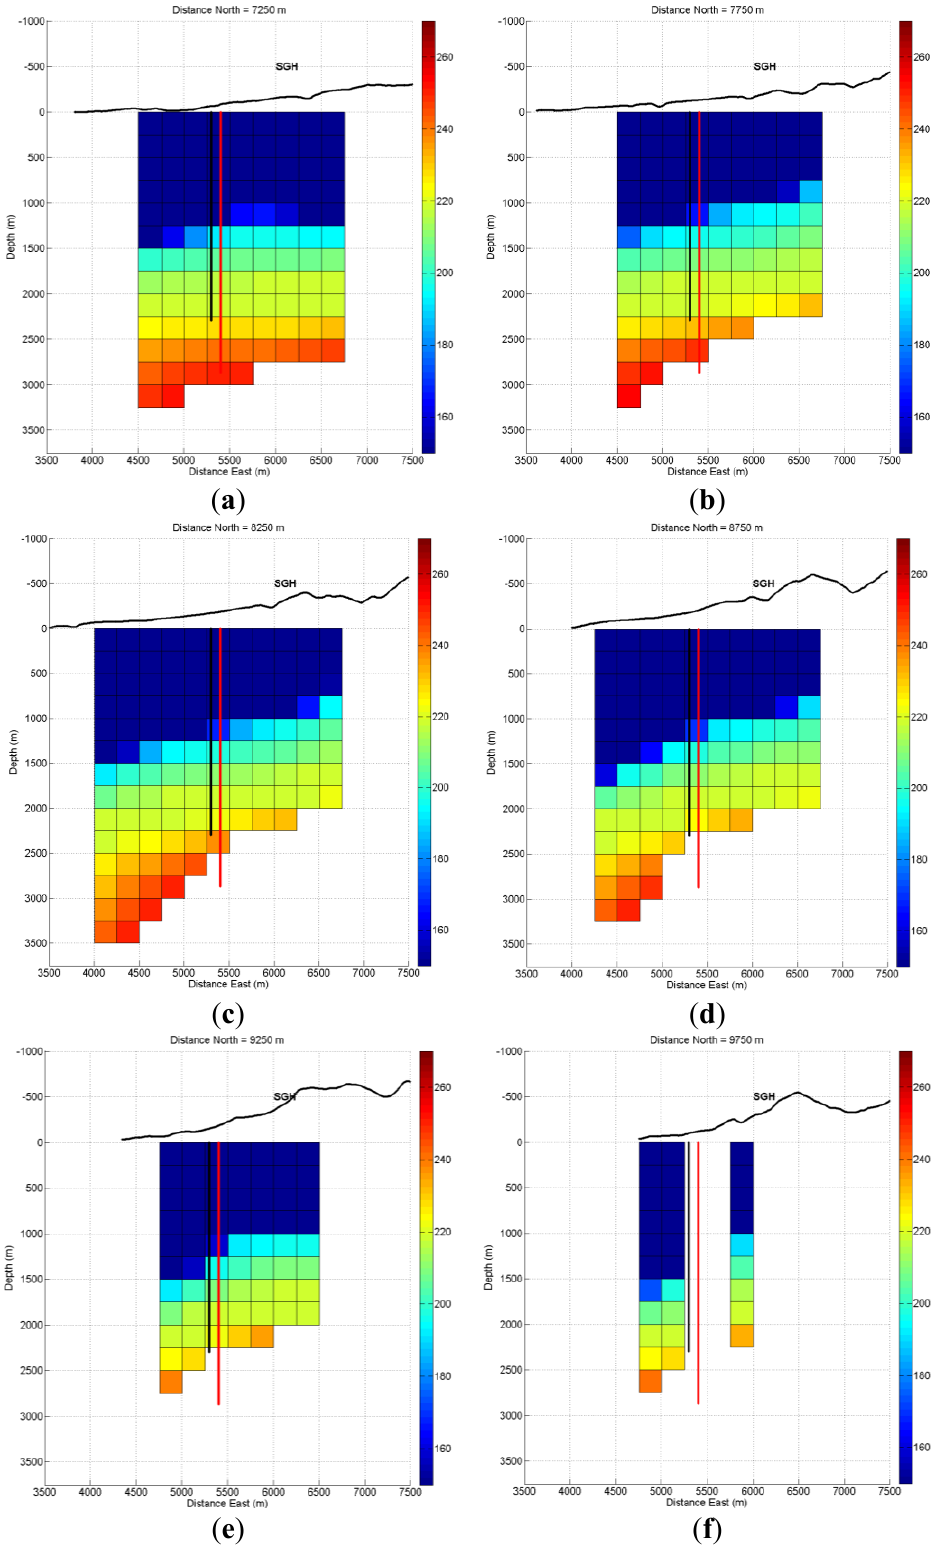
Figure 12. ( a – f ) E-W Cross-sections through the southwestern portion of the temperature model estimated from the seismic velocity anomaly data. This region corresponds to seismic anomaly associated with the known geothermal system. Black line indicates the track of well MON-1 and the red line indicates the track of well MON-2. SGH (St. George’s Hill). The colour scale indicates temperature in degrees